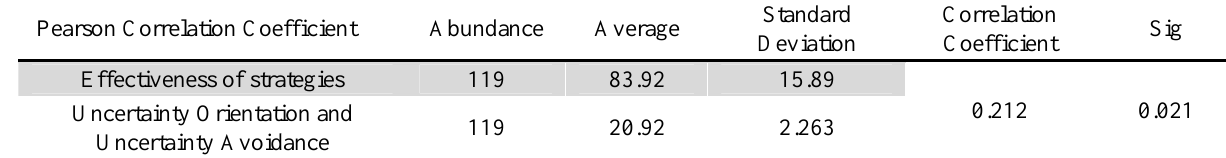
Standard Deviation